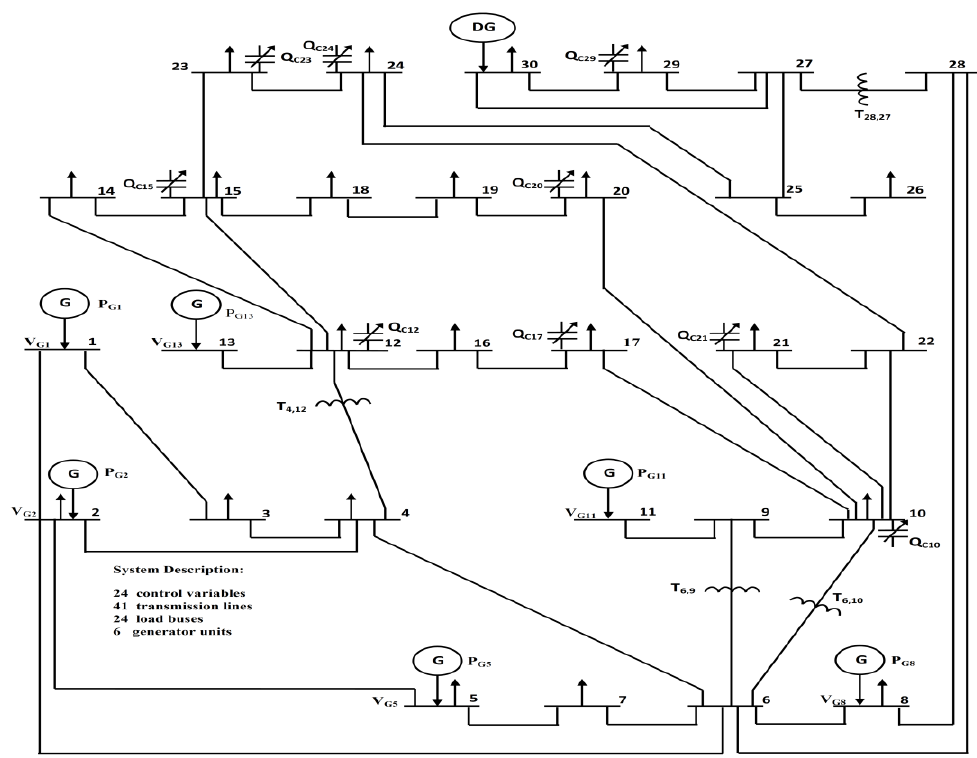
Figure 3. One line diagram of IEEE 30-bus network.